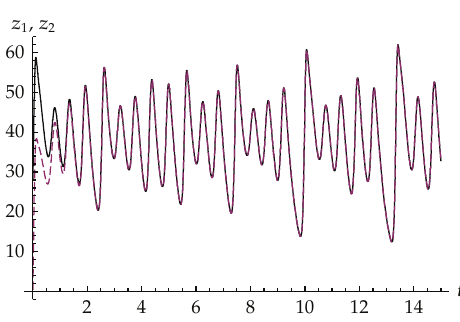
Figure 14: Synchronized signals z 1 ; z 2 (cid:3) α (cid:8) 0 . 99 (cid:4) .